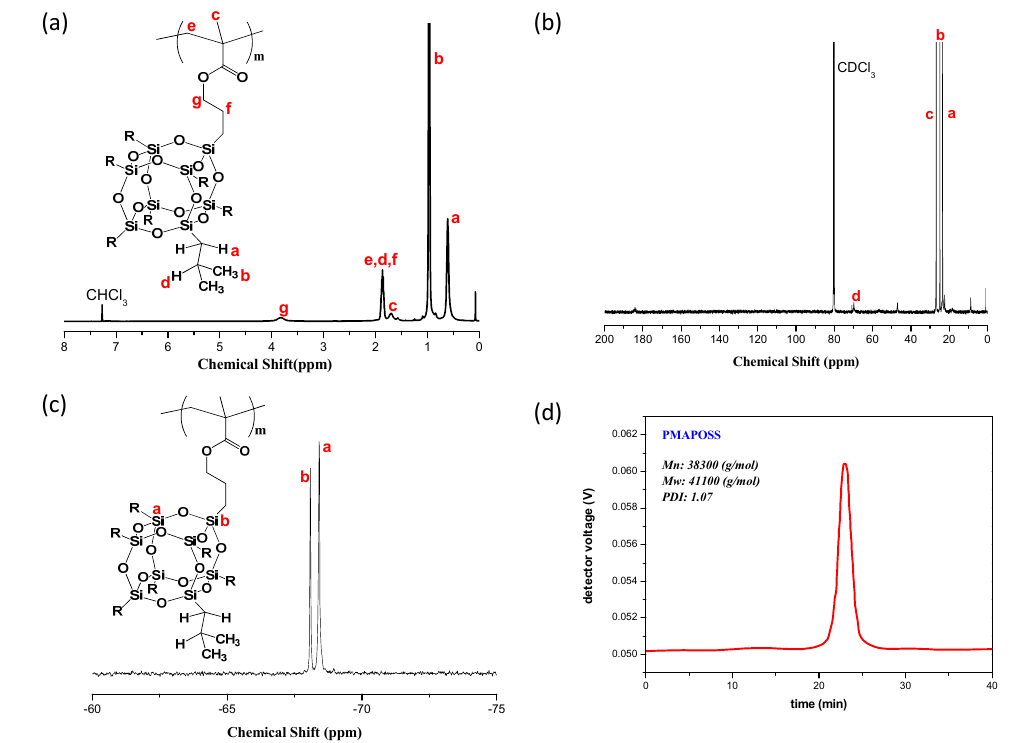
Figure 1. Characterization of PMA-POSS homopolymer: ( a ) 1 H; ( b ) 13 C; and ( c ) 29 Si NMR spectra; and ( d ) MALS analysis.